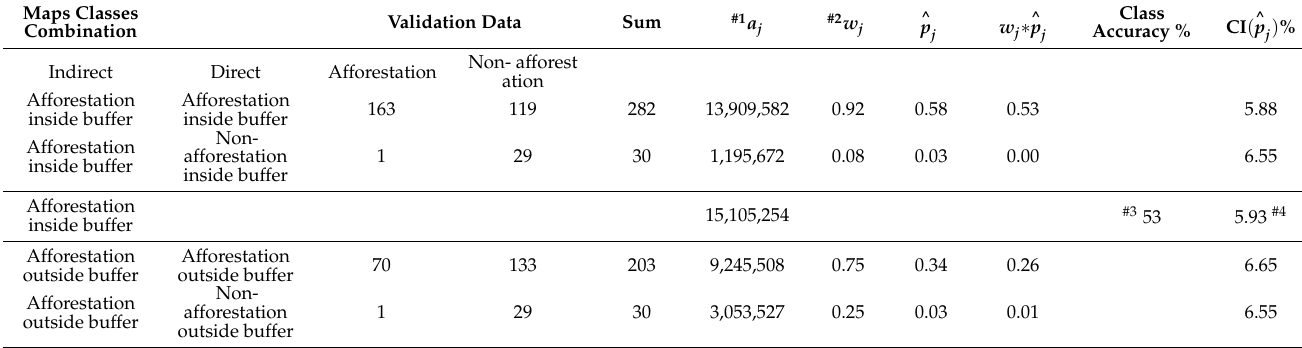
Table A3. Per-class accuracy assessment for the indirect